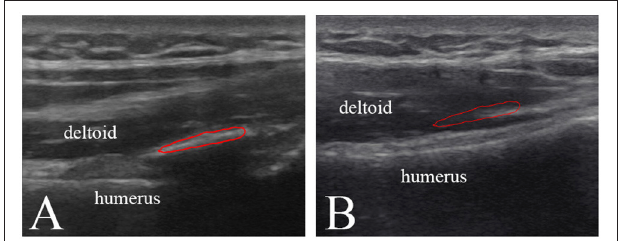
FIGURE 2 | Ultrasound greyscale images of the injured left shoulder joint (A) and the uninjured right shoulder joint (B) of participant No. 2. Red profile in (A) and (B) represents the HO segmented from the surrounding soft tissues and the normal muscle tissue selected on the corresponding position, respectively.